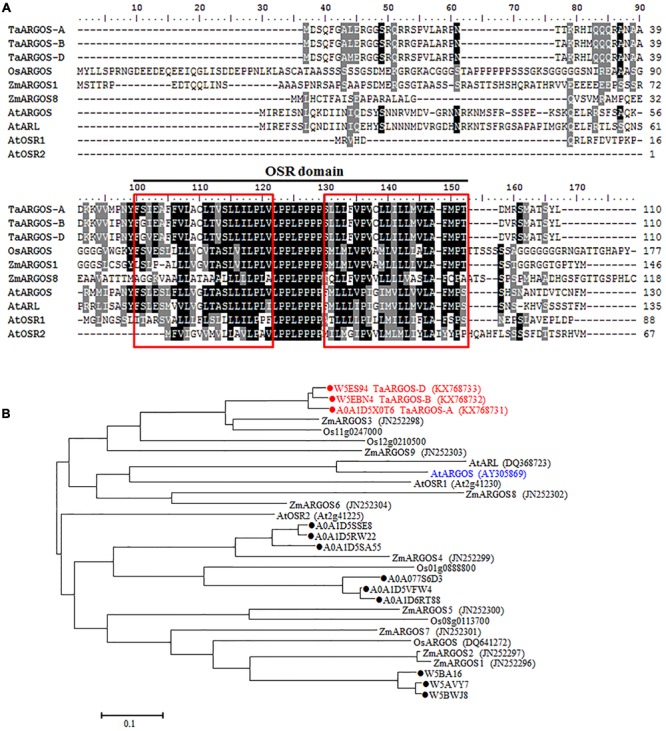
Sequence alignment and phylogenetic analysis of the TaARGOSs and other ARGOS proteins. (A) Amino acid sequence alignment of the TaARGOSs and the ARGOS from Arabidopsis AtARGOS (Hu et al., 2003), AtARGOS-like (Hu et al., 2006), AtOSR1 (Feng et al., 2011), and AtOSR2 (Qin et al., 2014), rice OsARGOS (Wang et al., 2009), and maize ZmARGOS1 (Guo et al., 2014) and ZmARGOS8 (Shi et al., 2015). Consensus sequences (100 and 75%) are exhibited in black and gray shading. The black line represents the conserved OSR domain. Red boxes indicate the putative transmembrane helices. (B) Phylogenetic tree based on amino acid sequences indicating the relationships of TaARGOSs with other plant ARGOS proteins. The accession numbers of the amino acid sequences are given in brackets. Twelve wheat protein sequences from the UniProt databases were indicated by dots. ZmARGOS2 is an allele variant of the ZmARGOS1 gene.